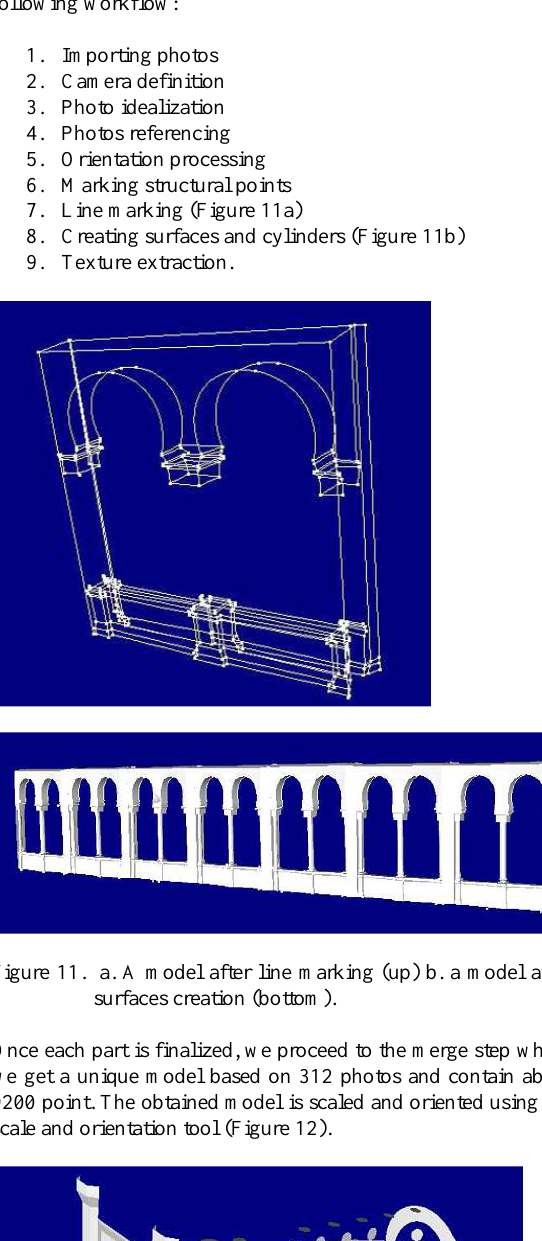
Figure 10. photography positions for a narrow corridor.